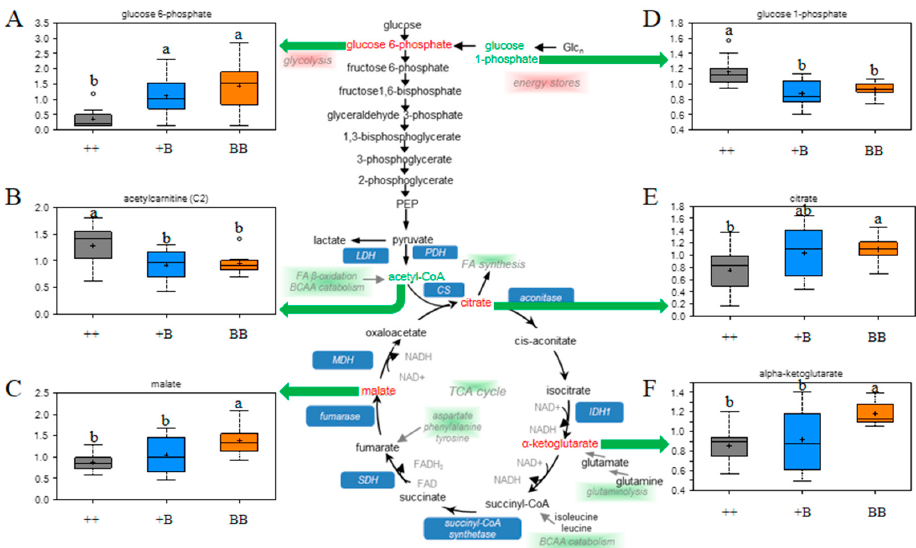
Figure 4. Changes in energy metabolism in FF samples. Note: a, b represent means with different superscripts in box plots have a significant difference ( p ≤ 0.05), box plots with the ab superscript indicate no significant difference with a and b; the red font indicates that the concentration of biochemicals was elevated in BB with a significant difference ( p ≤ 0.05), and the green font indicates that the concentration of biochemicals declined in BB with a significant difference ( p ≤ 0.05). ( A ) Box plots for glucose 6-phosphate in FF samples; ( B ) Box plots for acetyl-CoA in FF samples; ( C ) Box plots for malate in FF samples; ( D ) Box plots for glucose 1-phosphate in FF samples; ( E ) Box plots for citrate in FF samples; ( F ) Box plots for alpha-ketoglutarate in FF samples.